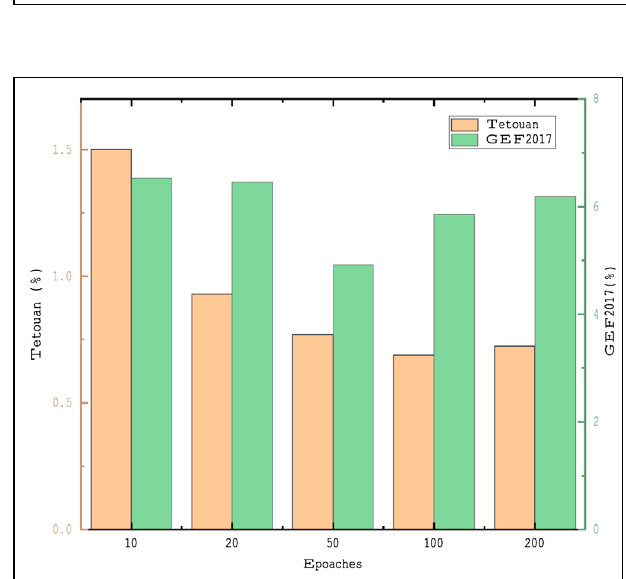
FIGURE 8 | Mean absolute percentage error with different number of epochs under hidden layers = 2 and hidden size =